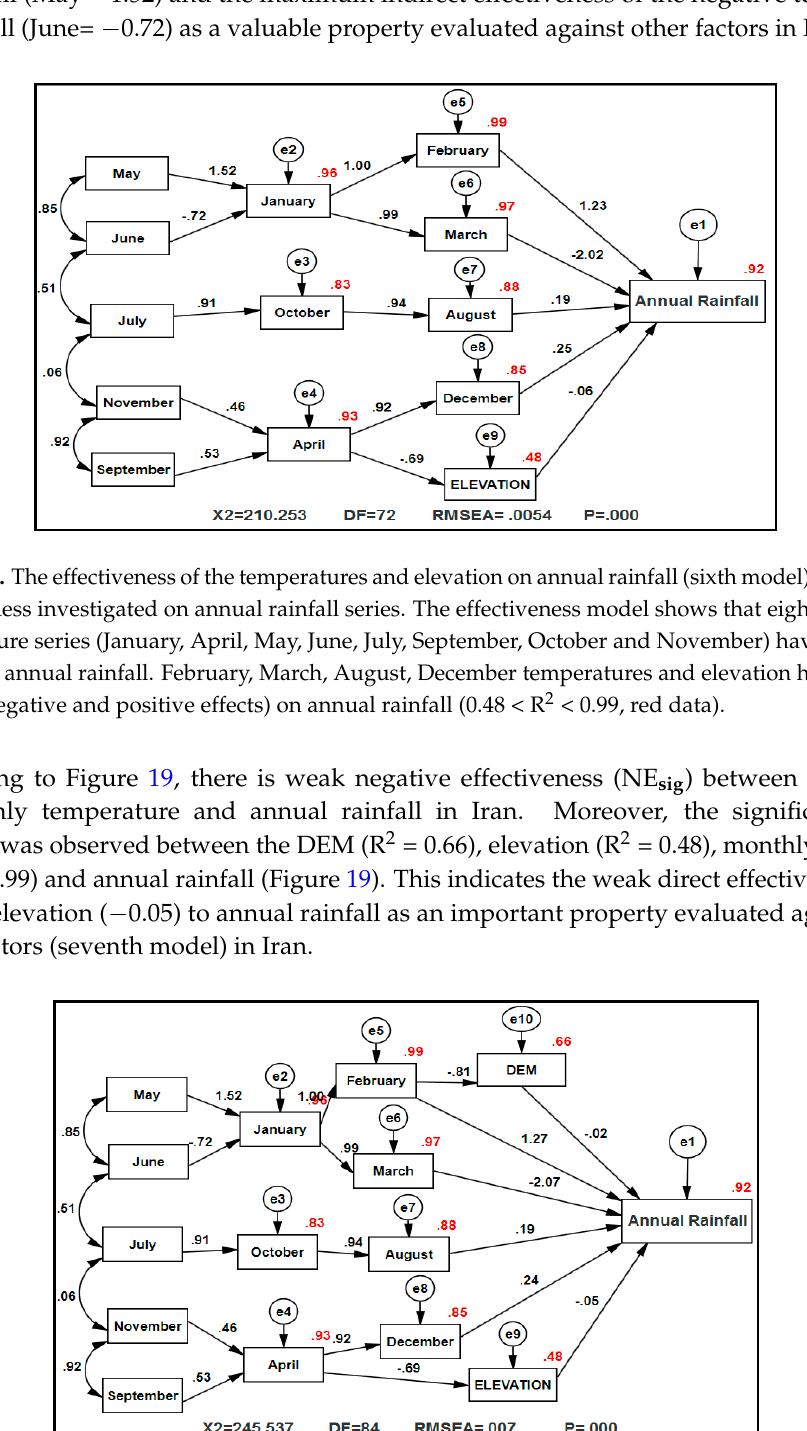
Figure 19. The effectiveness of the temperatures, elevation, and DEM on annual rainfall (seventh model).